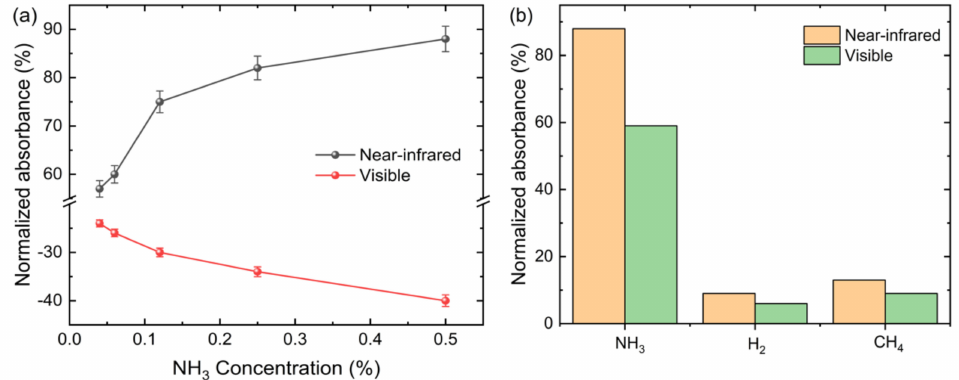
Figure 8. ( a ) Absorbance response changes as a function of NH 3 concentrations for visible and near-infrared wavelength range; ( b ) selectivity of the optical microfiber sensor against H 2 , and CH 4 .